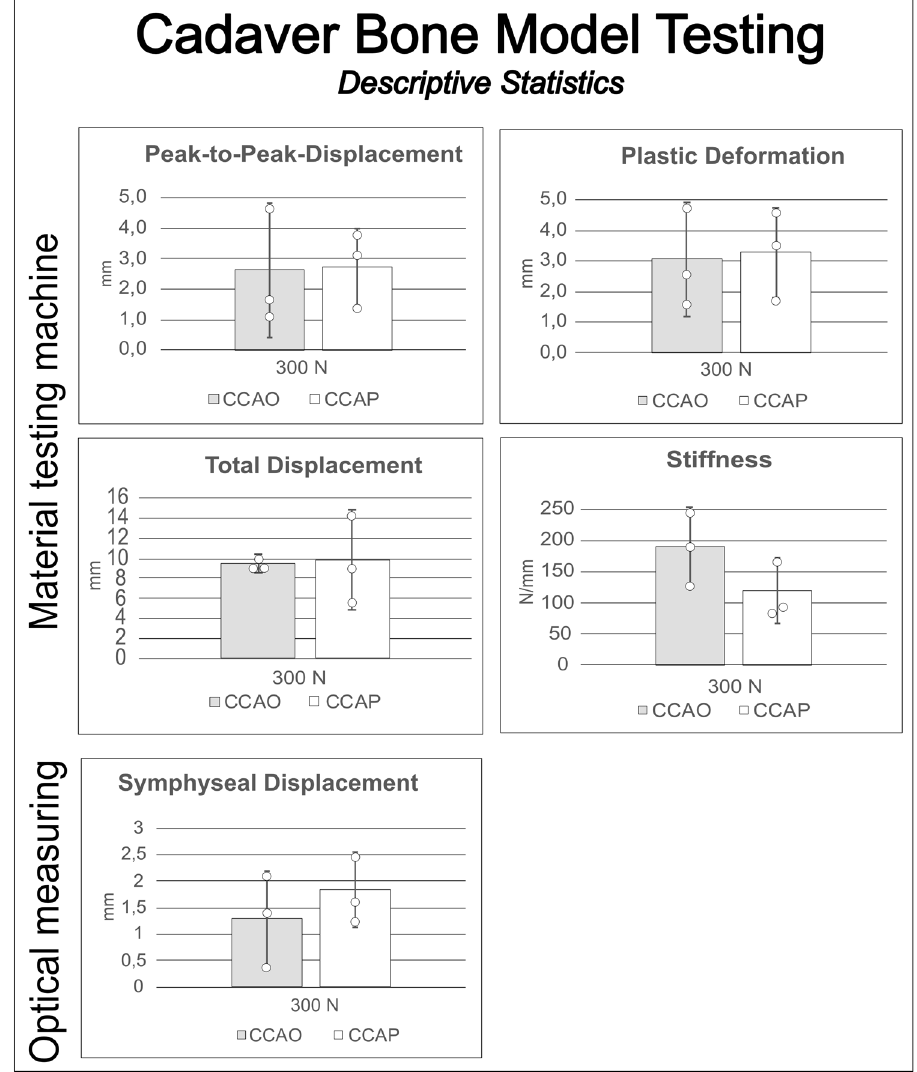
Fig. 6 Results of the cadaver biomechanical testing ( N = 3). Parameters were similar to those obtained using the synthetic bone model. The material testing machine generated a load – displacement curve from which peak-to-peak displacement, plastic deformation, total displacement, and stiffness were measured under two different cyclic load levels. The optical system measured changes in separation of the pubic branches (symphyseal displacement). Sample sizes were smaller and SP fi xation was not evaluated. White dots = individual